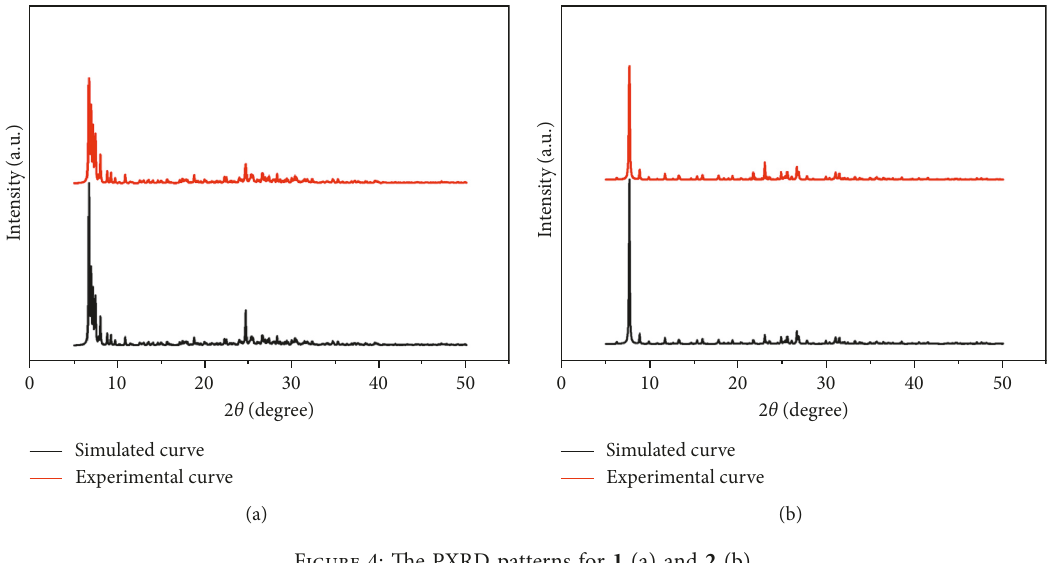
Figure 4: The PXRD patterns for 1 (a) and 2